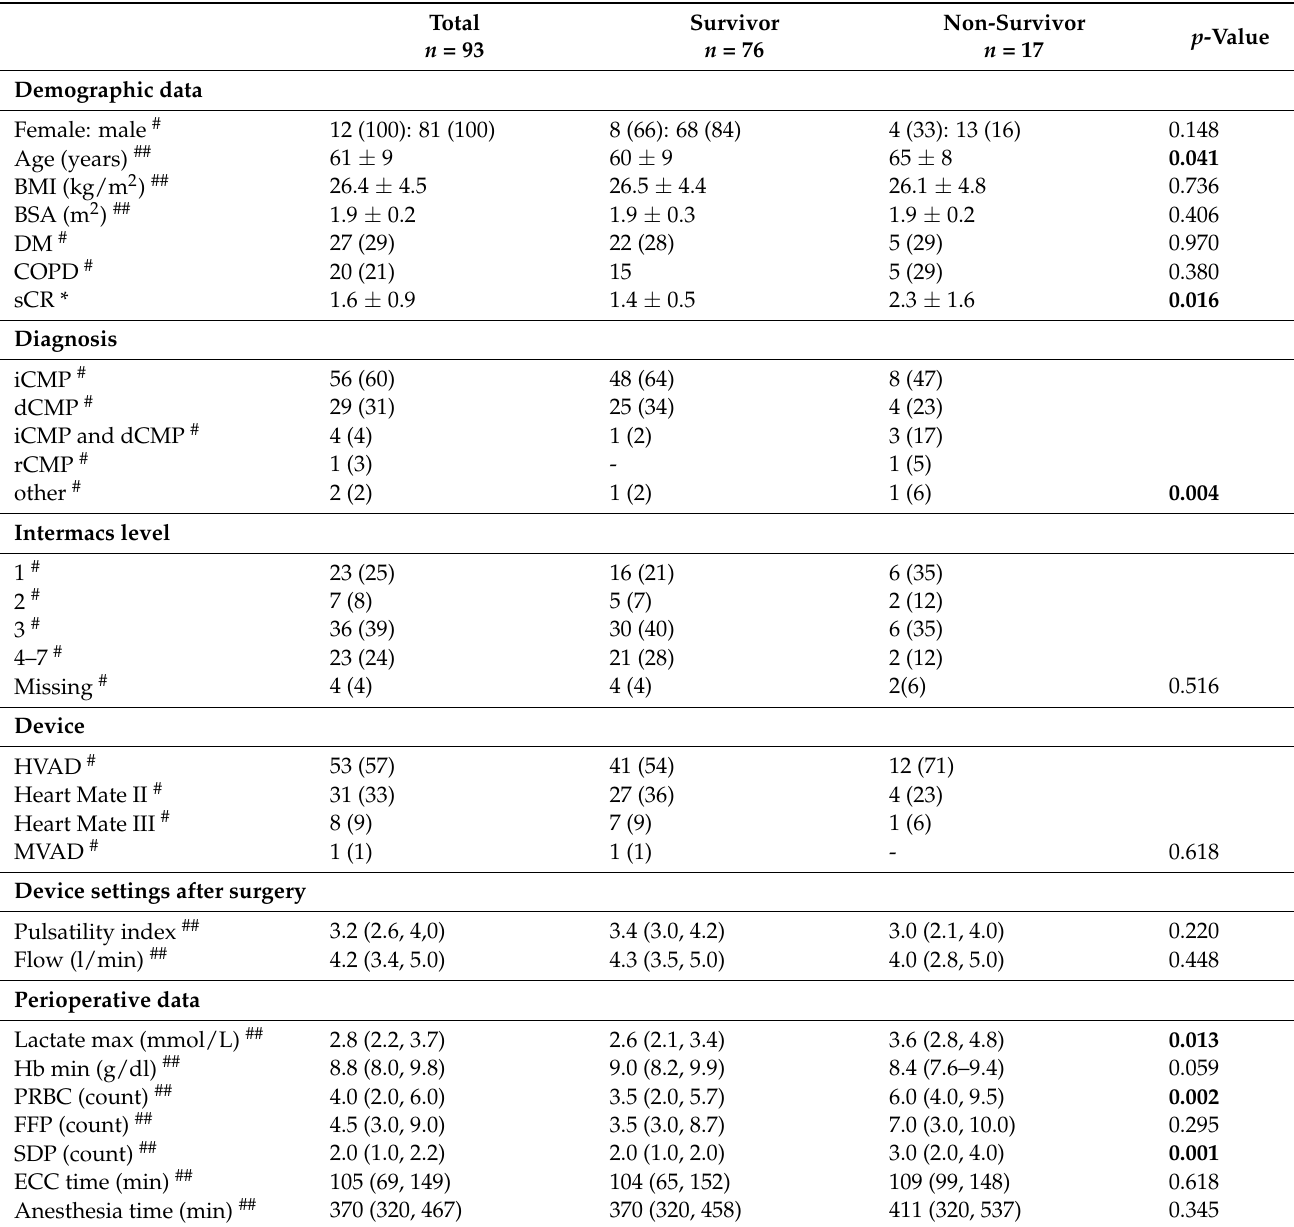
Table 2. Demographic and clinical data. Demographic and clinical data of hospital survivors and non-survivors. Total n = 93